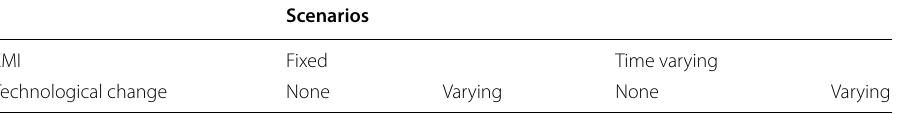
Table 4 Scenario